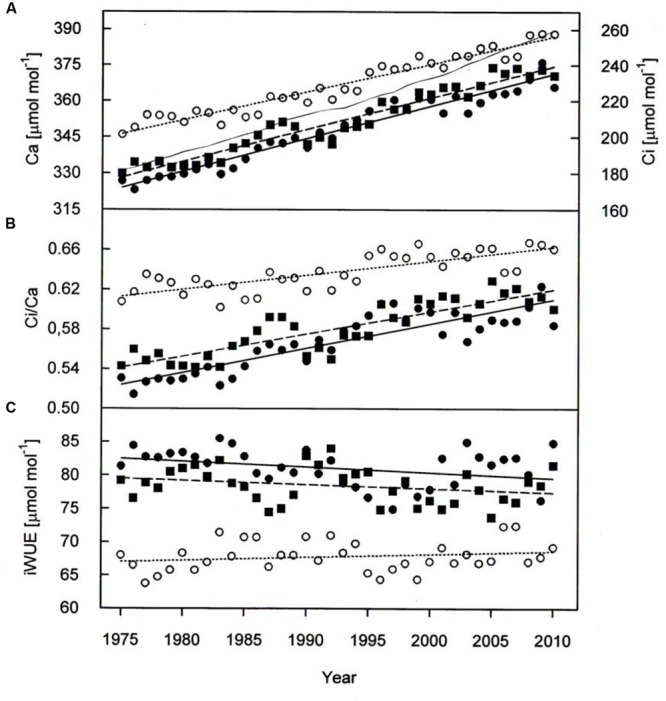
(A) Ambient armospheric CO2 concentration (Ca, thin solid line) Ci, (B)
Ci/Ca, and (C) iWUE chronologies of P. cembra (solid circle, solid line), P. abies (solid square, dashed line) and L. decidua (open circle, dotted line) between 1975 and 2010. See Table 2 for regression information.